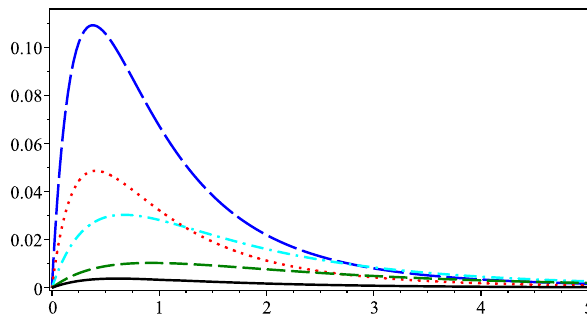
Fig. 1 The difference v − v newt (vertical axis in Km/s) as a function of distance (horizontal axis in kpc), where v is given by Eq. (32) and v ( r )/ r . The galaxies from top to newt is the Newtonian velocity GM bottom are as follows: NGC3031, NGC3627, NGC3521, NGC6946 and NGC7793. The galaxy NGC4736 is not shown, but for it always v − v < 0 . 7 newt